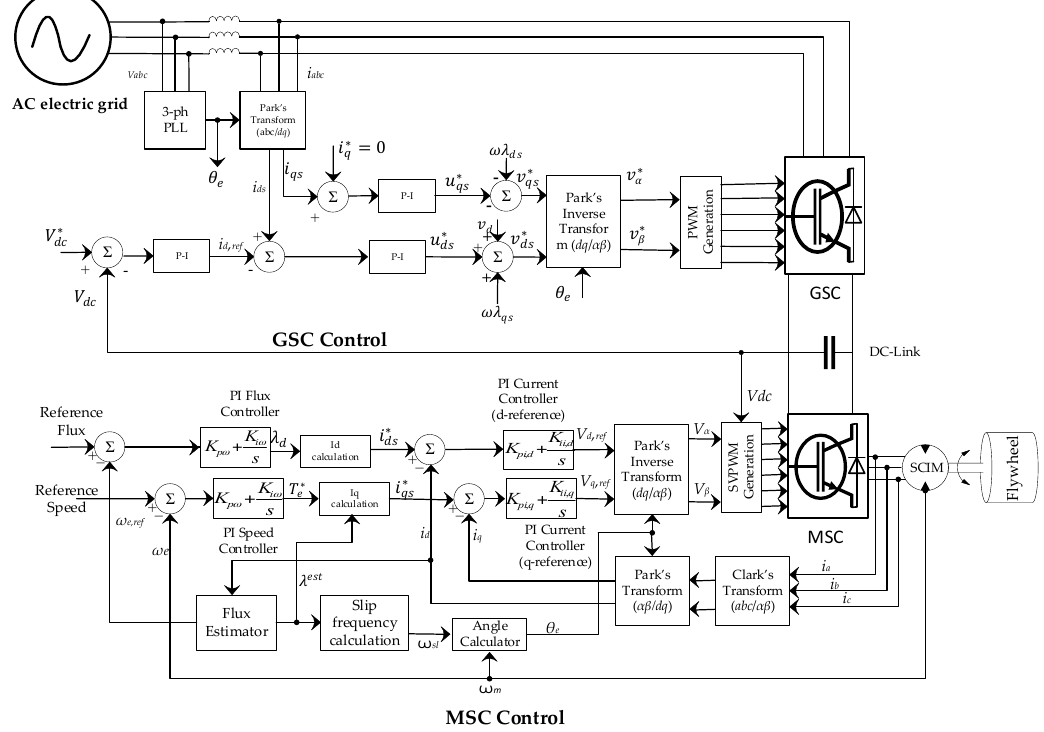
Figure 4. Control structure of machine side converter (MSC) and grid side converter (GSC) in squirrel-cage induction machine-based flywheel storage system (SCIM-FESS).